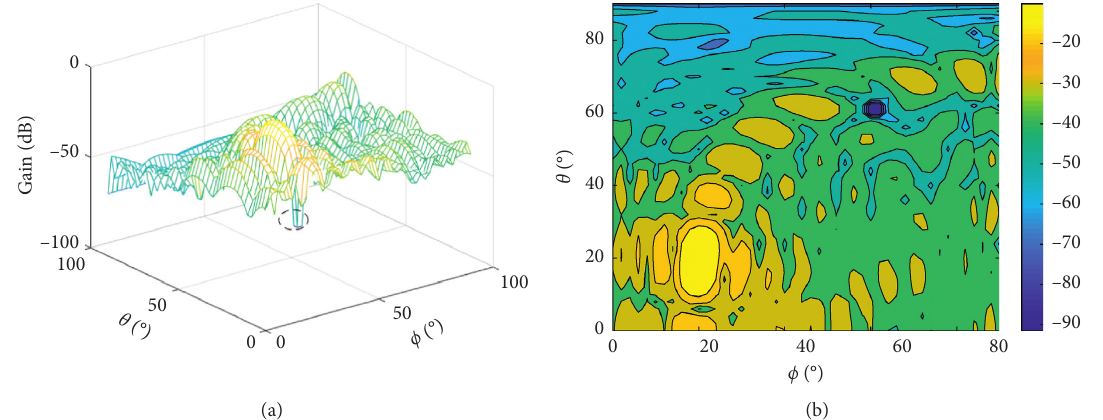
Figure 7: Polarized beampattern using the proposed method. (a) The 3D polarized beampattern. (b) The contour of polarized beampattern.